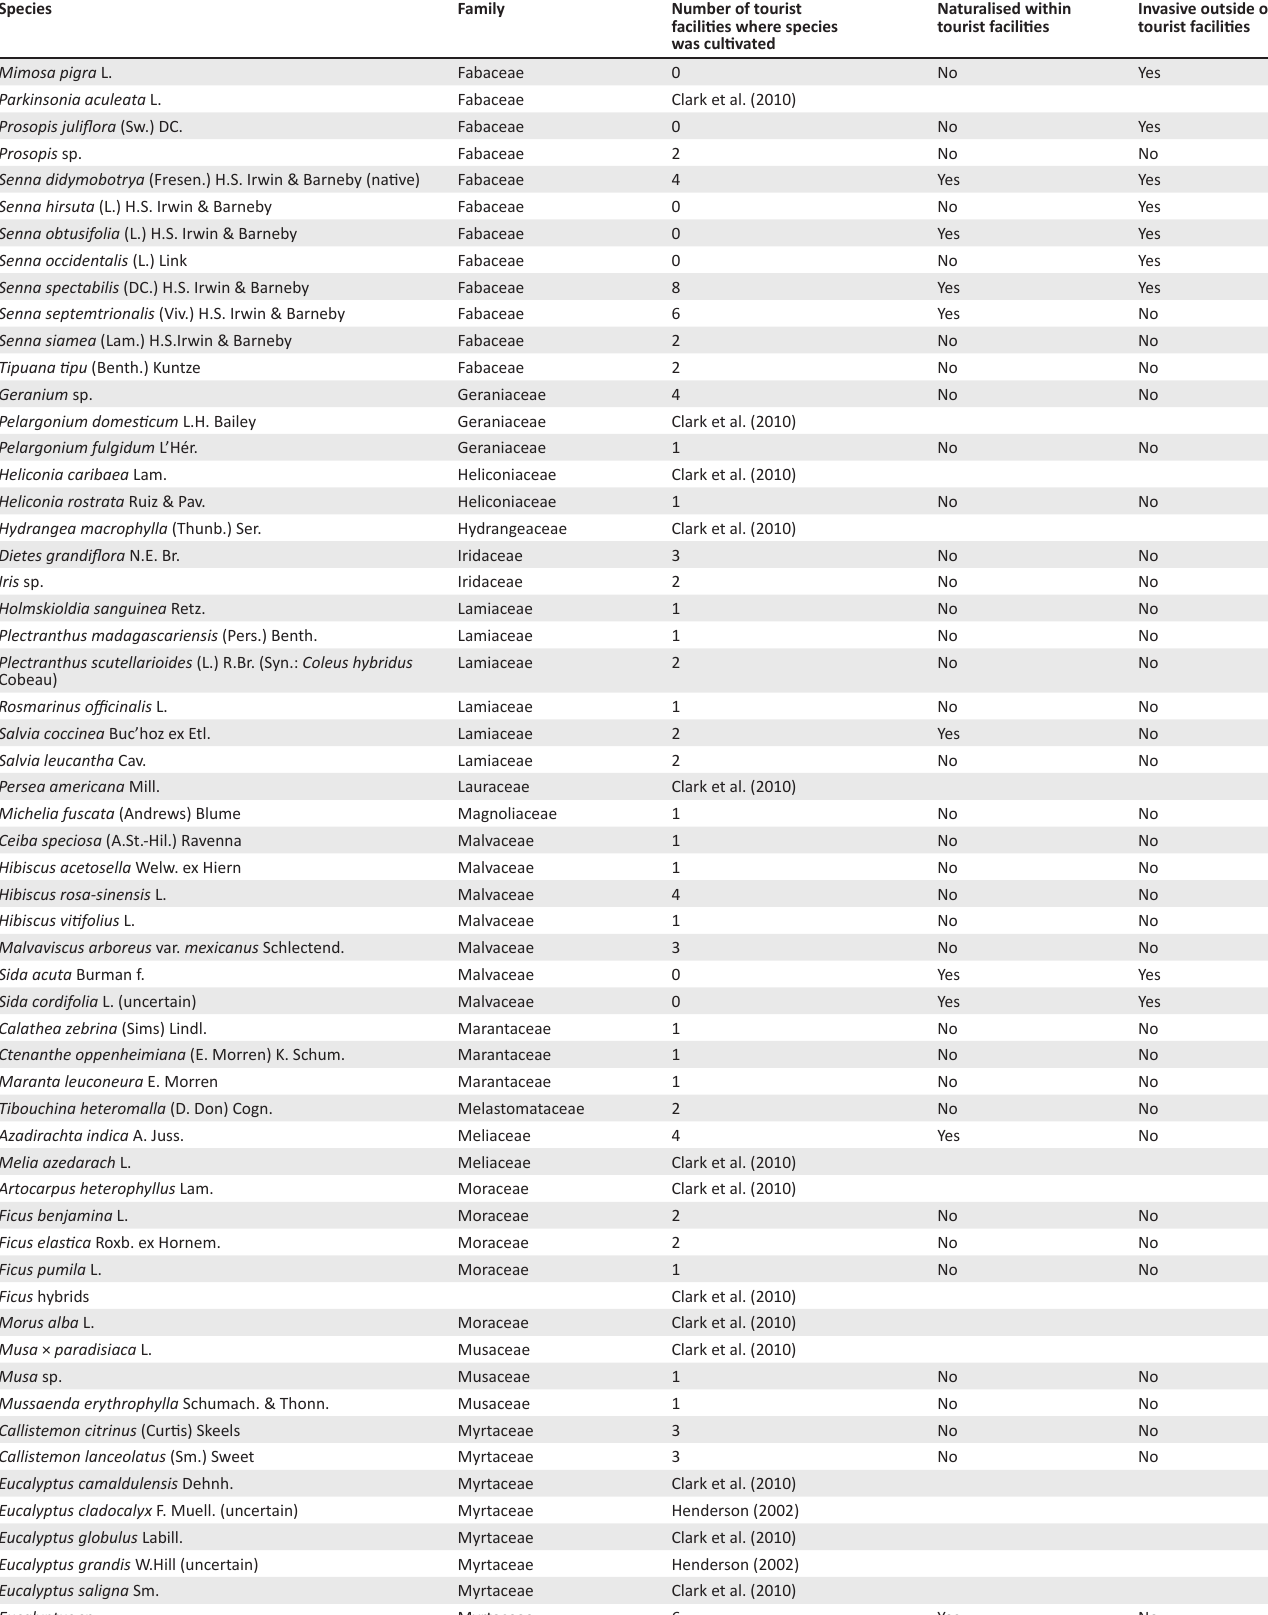
TABLE 1: (Continues...) Alien plant species, including some native plant species which may be growing outside of their natural range, recorded in the Serengeti-Mara ecosystem and immediate surrounds (excluding vegetable crops and grains).